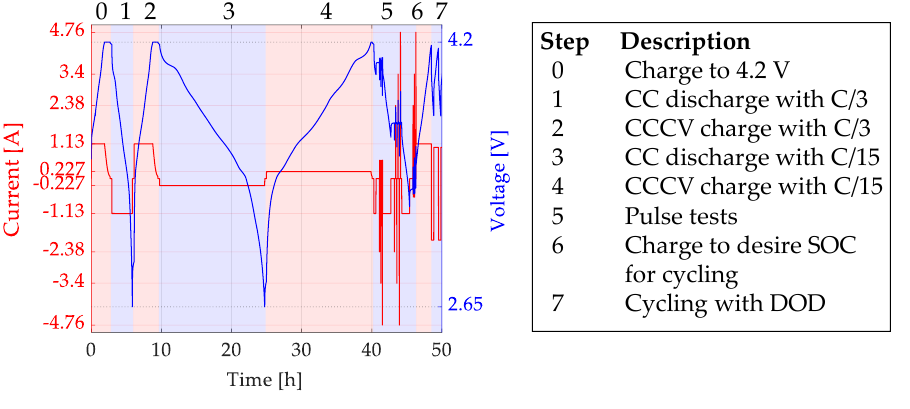
Figure 1. Check-up Figure 1. Check-up routine. For the cycling phase, the cells were charged up to a defined average SOC and then cycled with a defined DOD window. The charge/discharge currents were varied for dif- ferent cells. The selection of the average SOC has a direct influence on the pressure gradi- ent that the jelly-roll experiences during the cycling phase. Figure 2 shows a schematic of the pressure evolution over SOC of a cylindrical cell with a graphite anode. To vary the pressure gradient, the average SOC was set to 20%, 50%, and 70%. The highest pressure gradients due to cell breathing are reported for 20% and 70% average SOC, while cells at 50% SOC reveal only small pressure gradients [21]. Studies that meas- ured the can diameter change of cylindrical Si-containing cells are [7–9,16,17,22]. On this account, Willenberg [7,16,17] used the same cell used in this investigation. From [8,21,22], we assume a change of pressure in the jelly-roll produced mostly by the anode volume change and neglect the influence of the gas. The pressure is then a result of the metallic can confining the jelly-roll. As it is shown in the following section, these pressure gradi- ents have a direct influence on the results of our investigation. Figure 2. Schematic of the pressure evolution over the SOC of lithium-ion cells with graphite anode along with the average SOC and DOD selected for the cycling tests. Since no formation of inhomogeneities are expected for cycling at 50% average SOC (reference cell), a variation of currents and DODs is provided only for cells at 20% and 70% average SOC. The DOD is varied between 20% and 30% using three pairs of charge and discharge currents. Detailed values are given in Table 2. Both cycling phases lasted